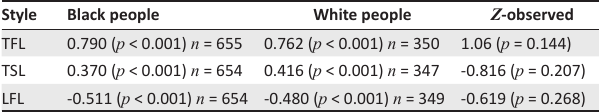
White people 347